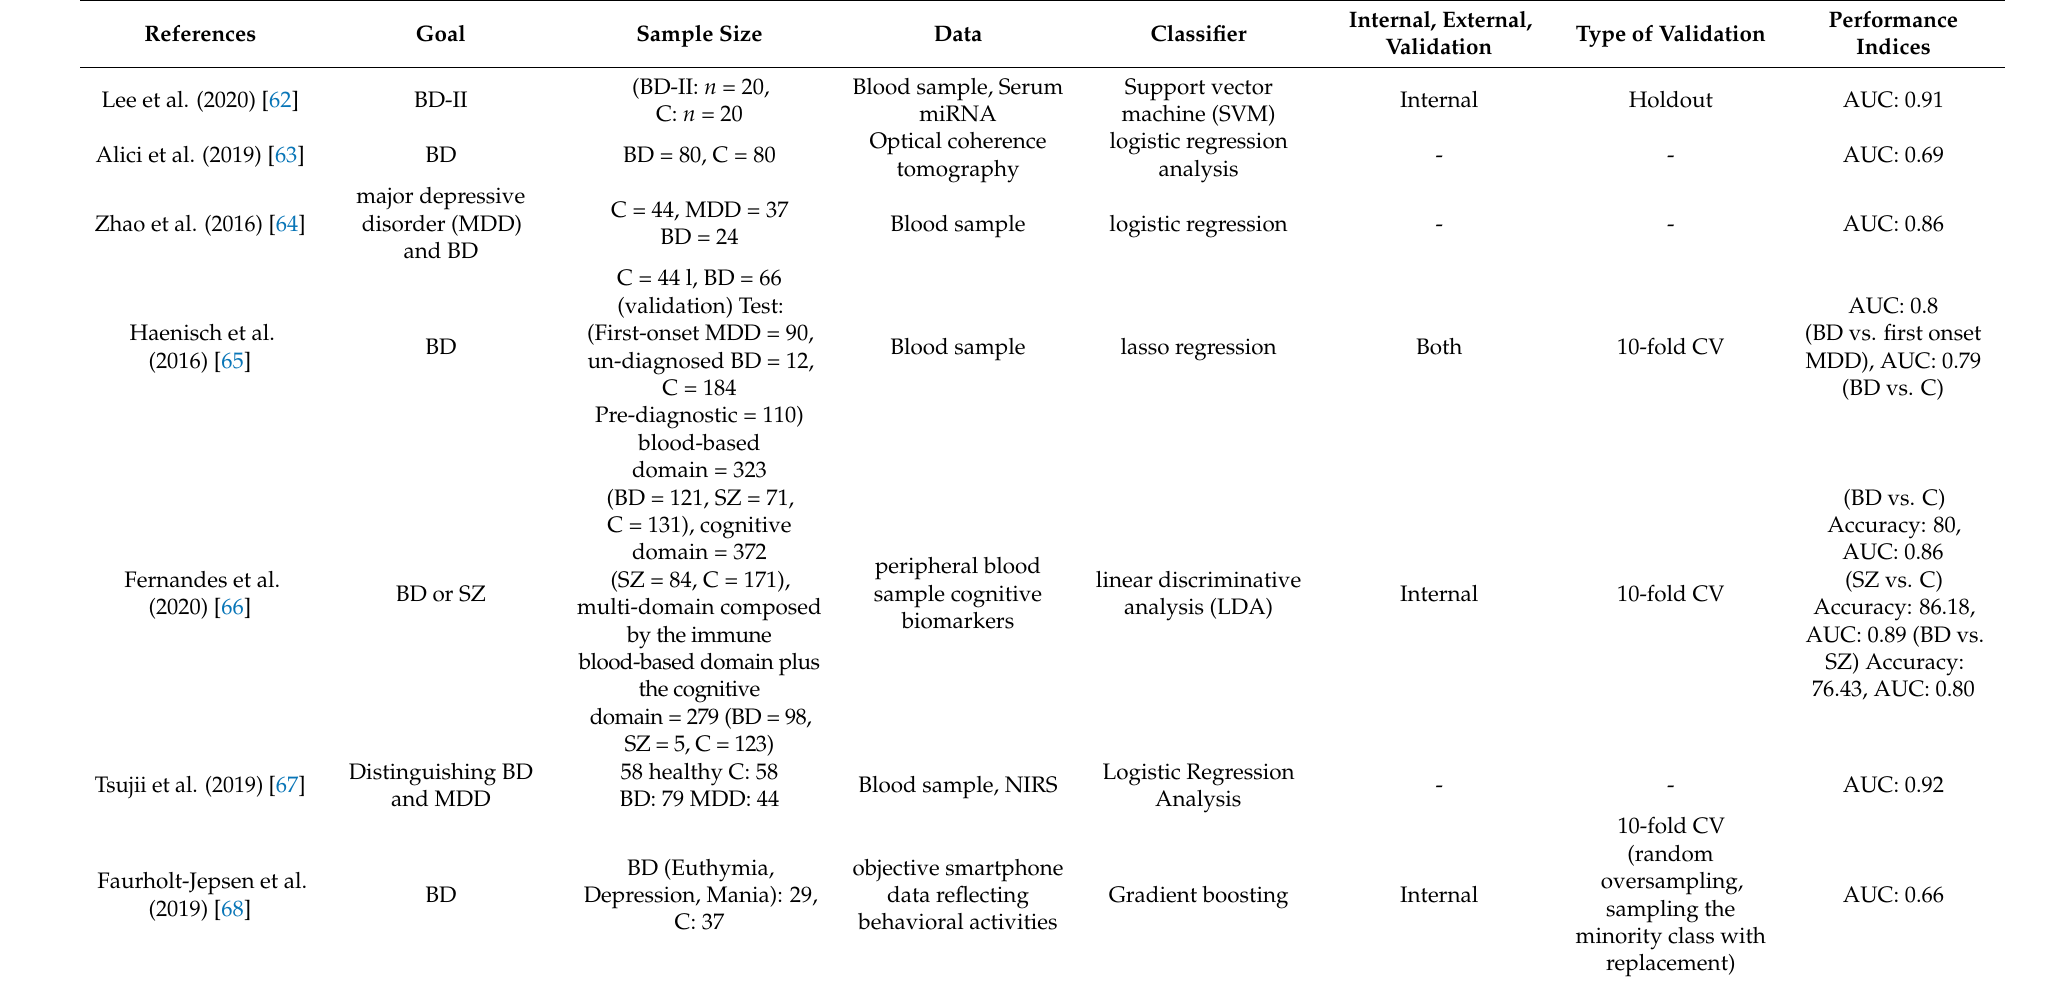
Table 1. CAD methods for mental and neurological